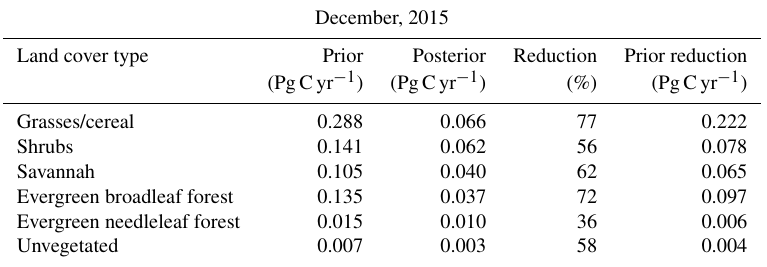
Table B4. Uncertainty reduction of total CO 2 Australian flux (in PgCyr − 1 ) classified by MODIS ecotype (December,